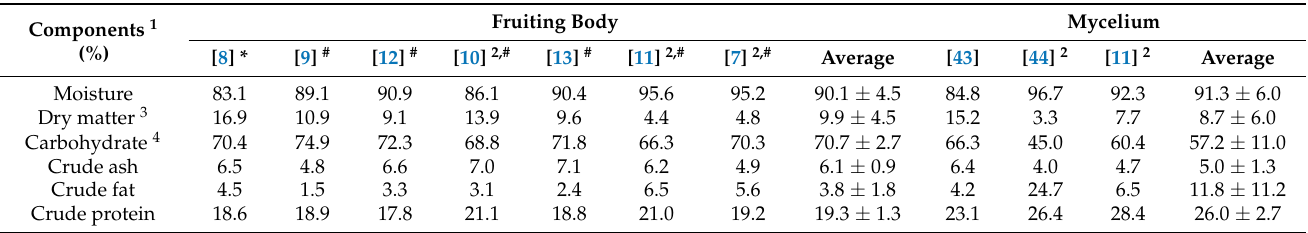
Table 1. Proximate composition of G. frondosa ’s fruiting body and mycelium. Components 1